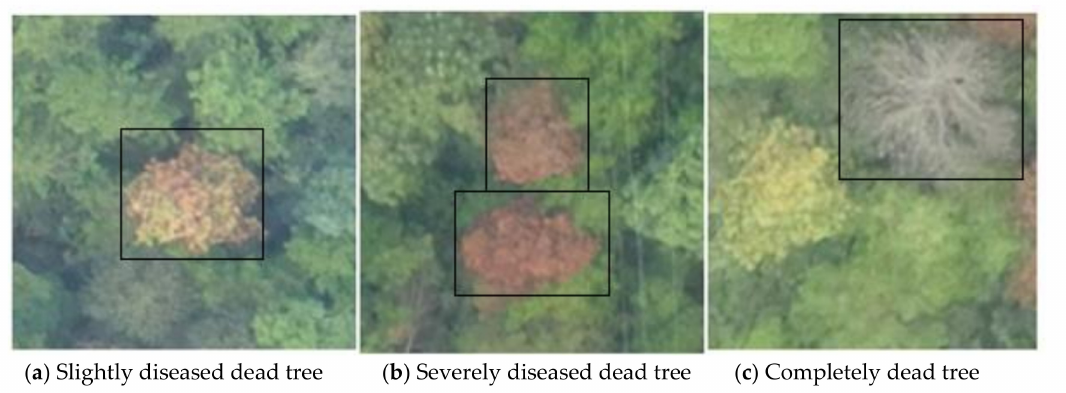
Figure 1. The symptoms of pine wood nematode dead